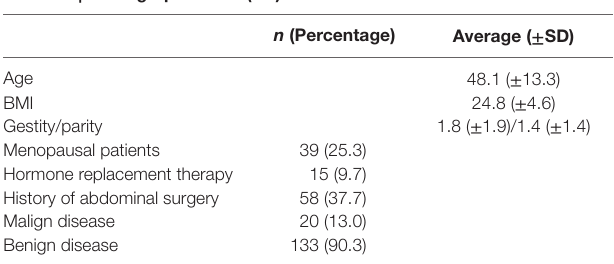
TaBle 1 | Demographic data